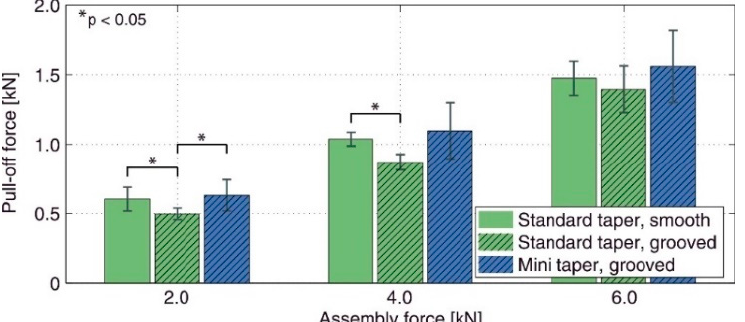
Figure 2. The influence of trunnion length, assembly force, and surface finish on the pull-off strength of 12/14 titanium trunnions assembled onto 28 mm CoCr head counterparts [24].